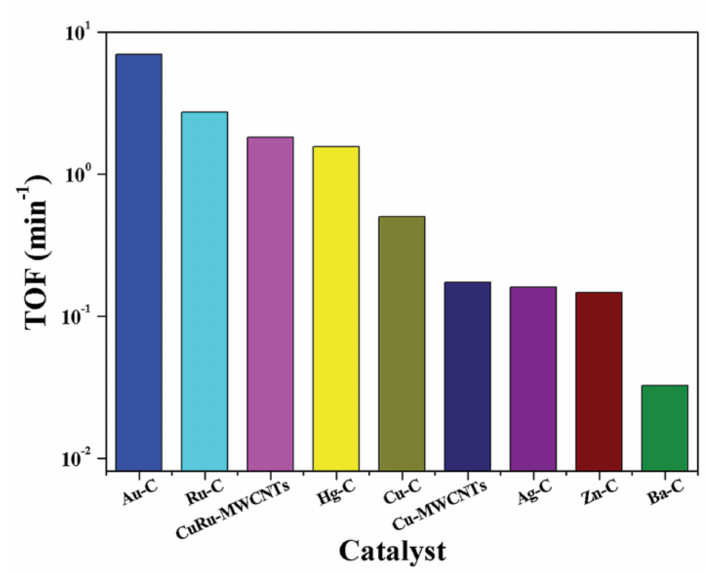
Figure 32. Calculated TOF values for Cu400Ru/MWCNTs in comparison with a variety of reported catalysts. The calculated TOF values for the different catalyst materials reported in literature and the Cu400Ru/MWCNTs catalyst material. (Reproduced with permission from ref. [333]. Copyright 2015 the Royal Society of